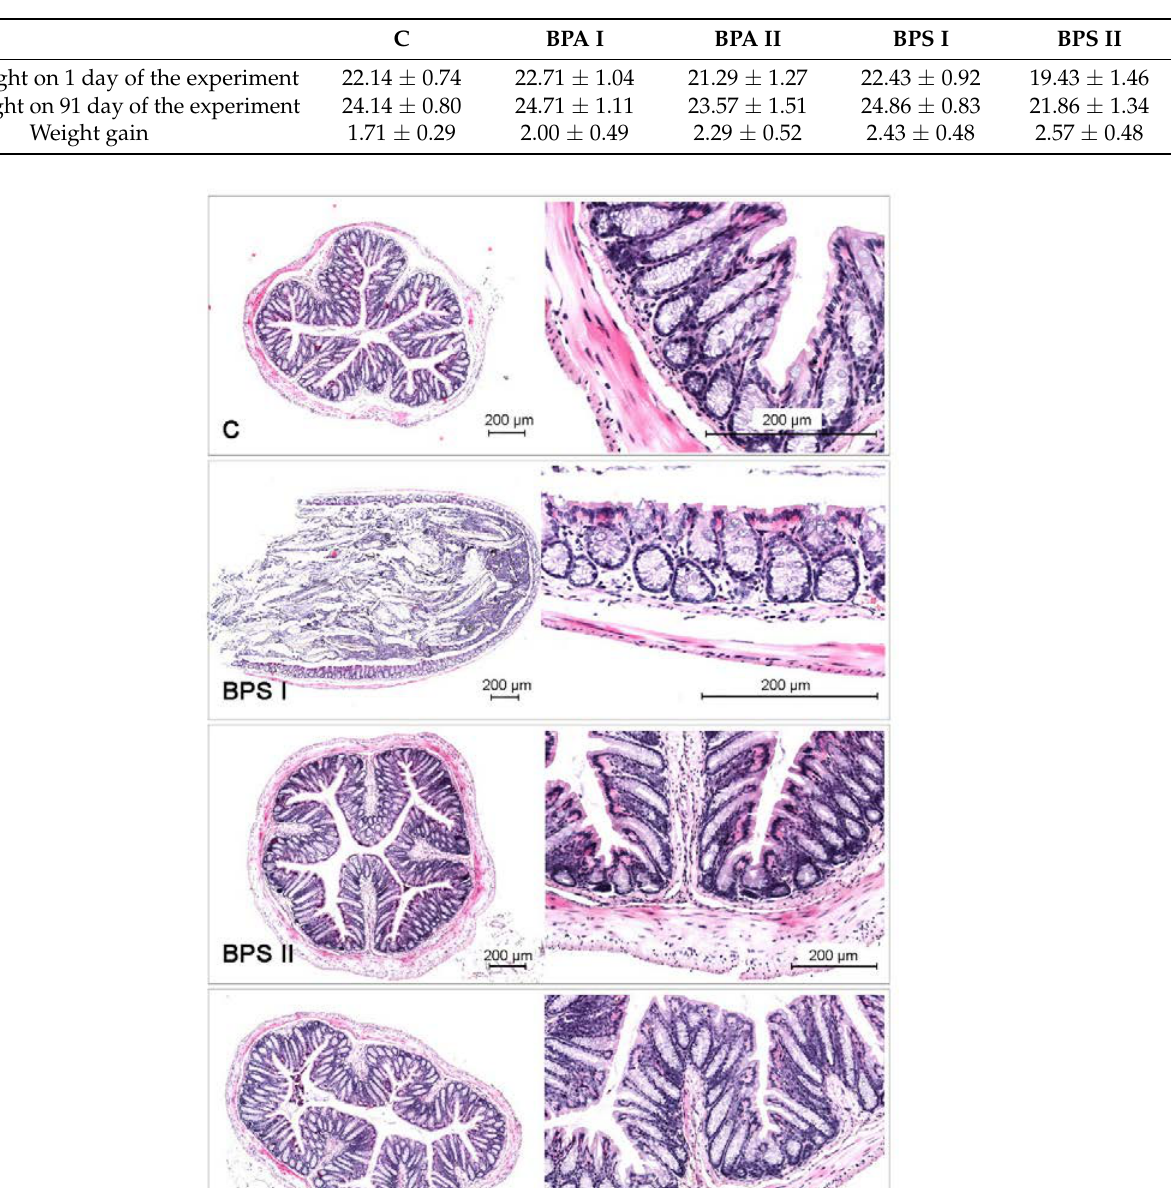
Table 3. Weight of animals on 1 and 91 days of experiment and weight gain observed during the investigations (g ± SEM).